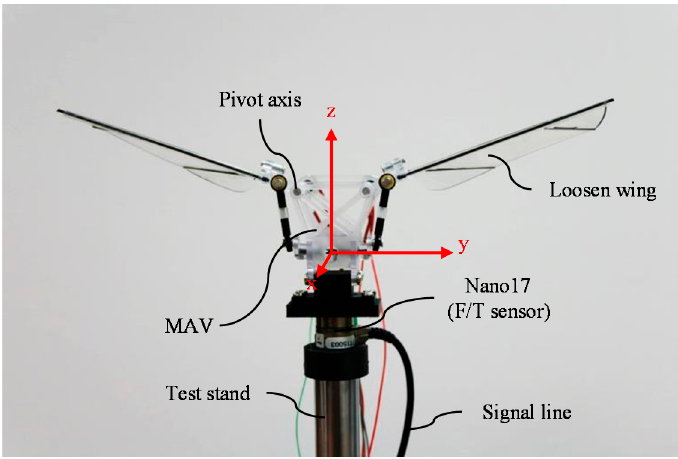
Figure 14. Experimental setup.